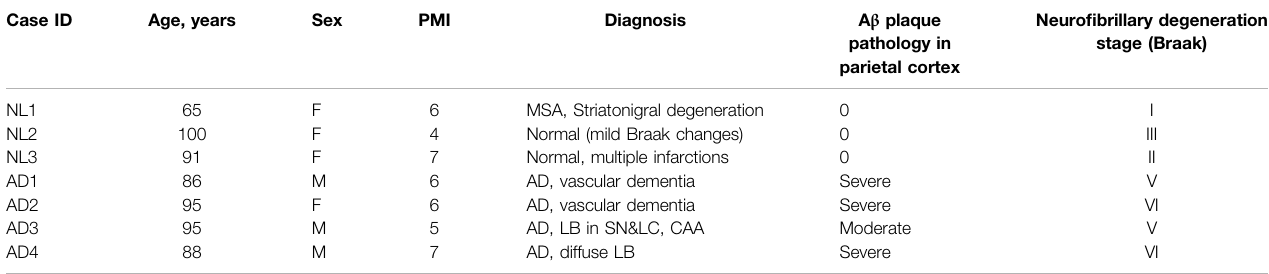
TABLE 2 | Case information for human